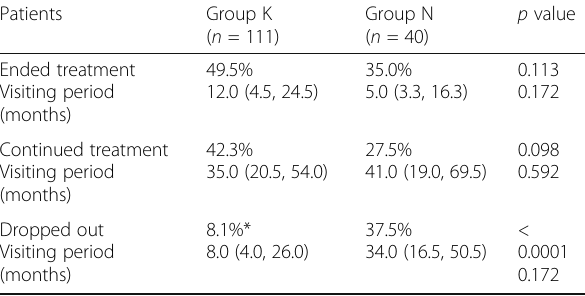
Table 4 Duration of hospital visits and outcomes